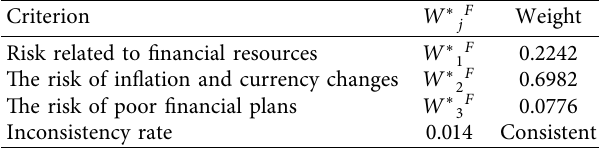
Table 10: Average weights of financial risk criteria.